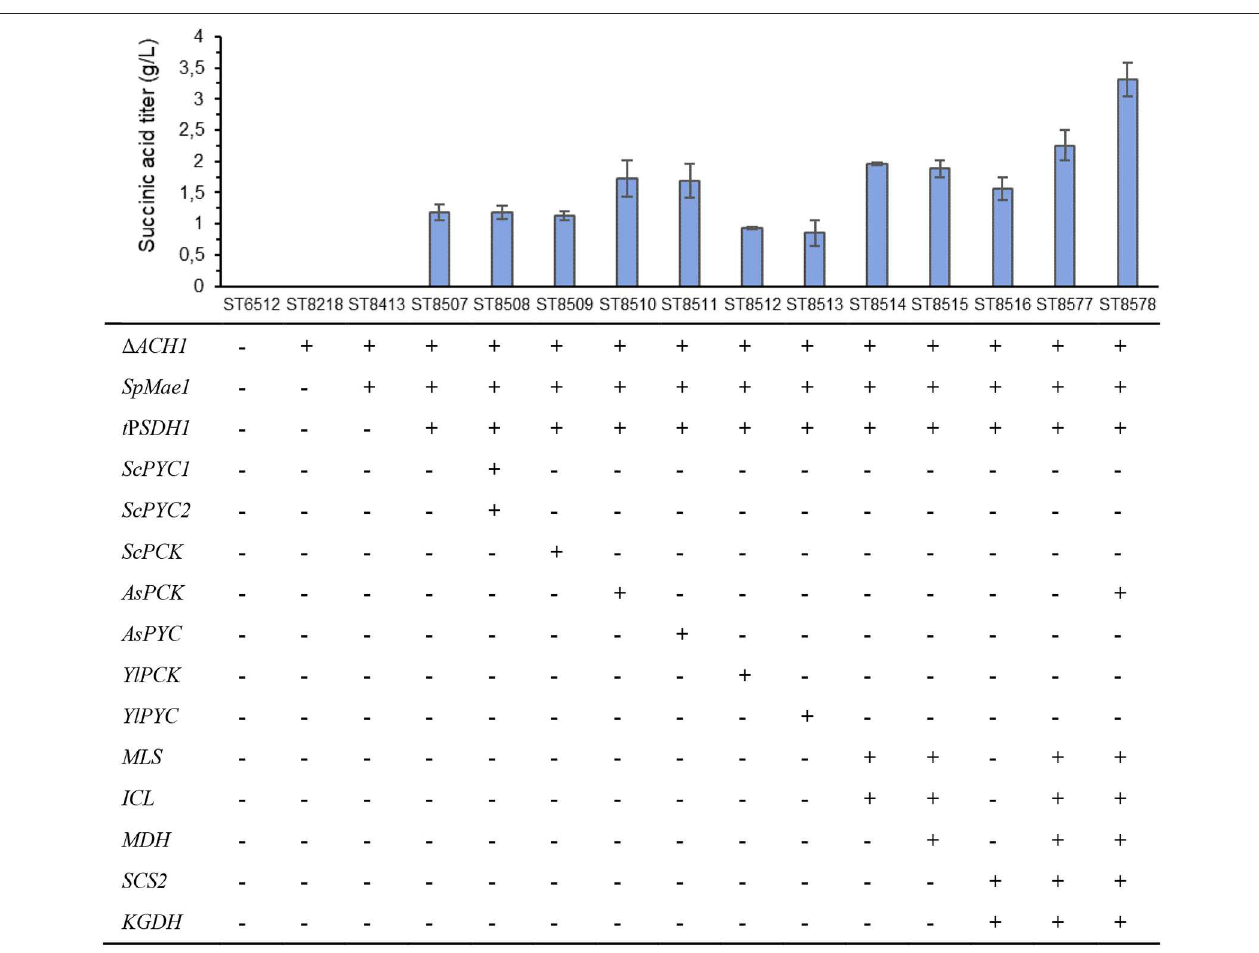
FIGURE 2 | Succinic acid production by engineered strains of Y. lipolytica . The strains were cultivated on YP medium with 5% v/v of glycerol as carbon source in deep-well plates for 4 days. The highest producing strain ST8578 was selected for further study. The values are averages from three biological replicates, the error bars show the standard